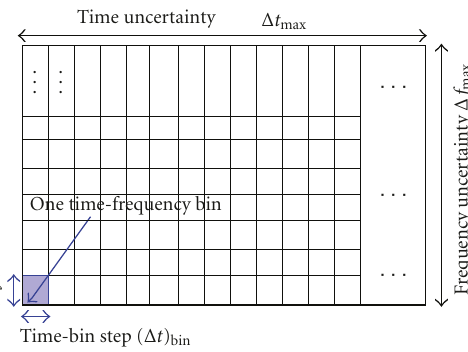
Figure 1: Illustration of the time/frequency search